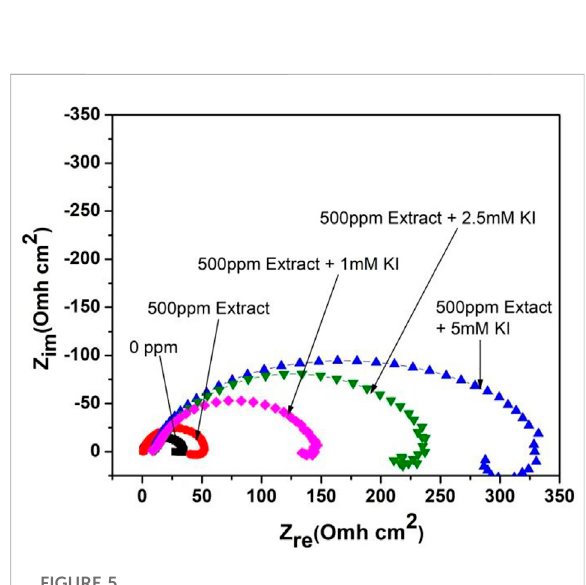
FIGURE 5 Nyquist diagrams for 1018 steel corrosion in acid media with and without 500 ppm of M. sativa and the addition of different KI concentrations at 60 °